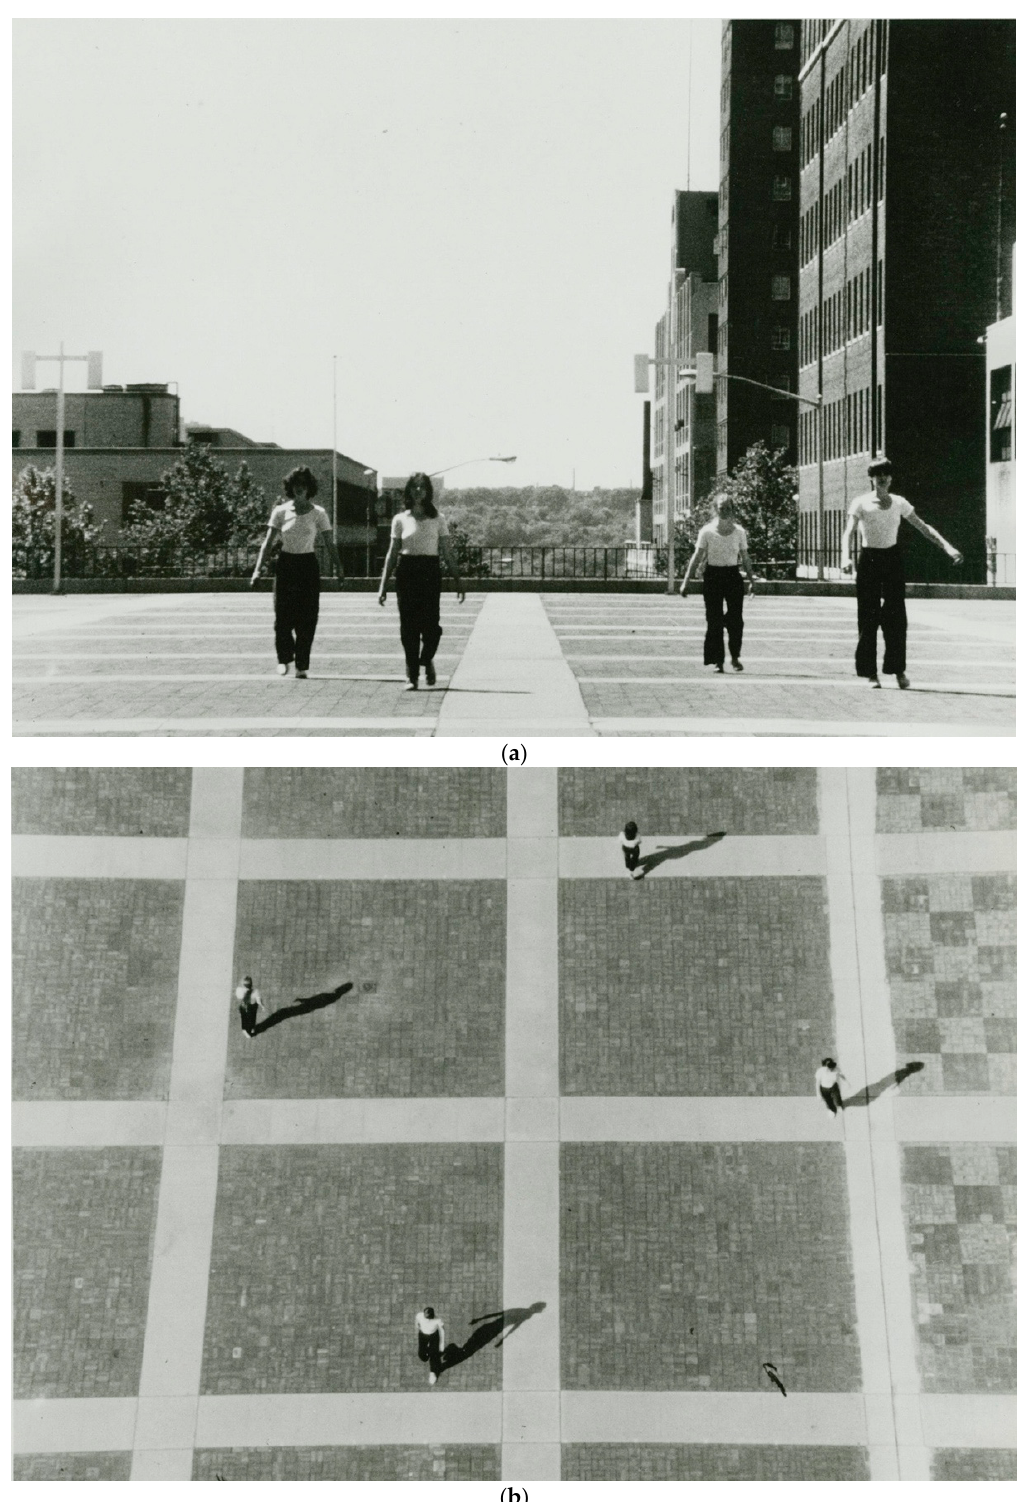
Figure 3. ( a , b ) Babette Mangolte, Calico Mingling (1973), with Susan Brody, Lucinda Childs, Nancy Fuller, and Judy Padow